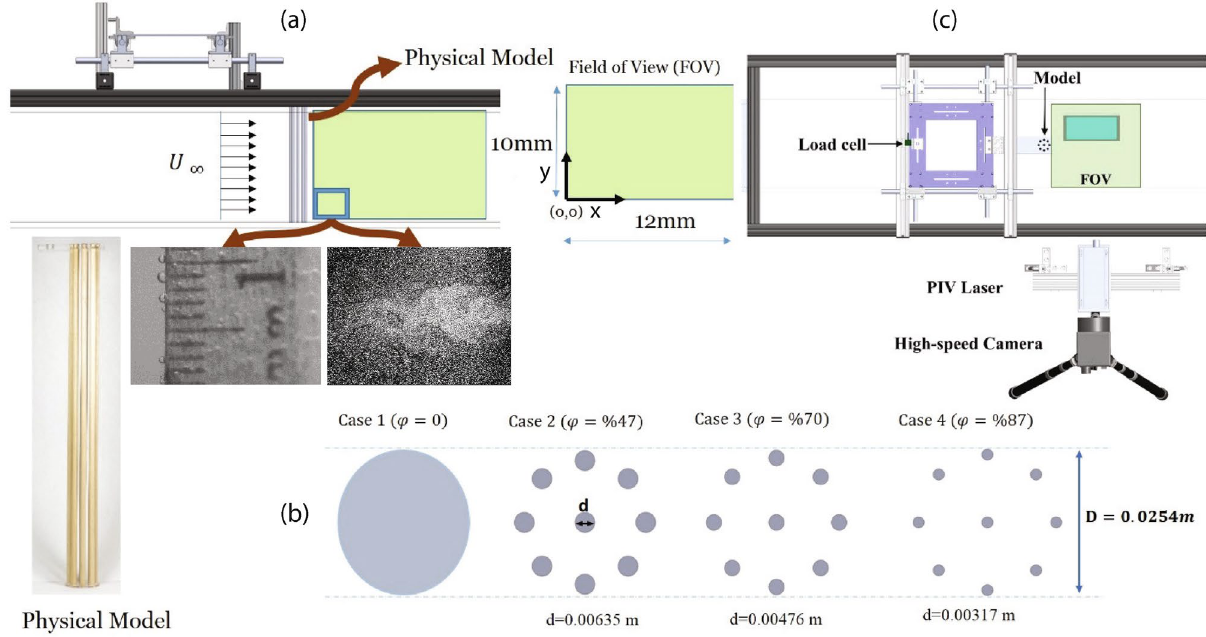
Figure 12. Schematic of the experimental setup and field of view (FOV) located in the mid-depth. ( a ) Side view of the experimental setup. ( b ) a picture of one physical model along with path configurations for different porosities. ( c ) top view of the experimental setup with simplified mangrove root models. The closed-loop water tunnel cross-section is 25 cm × 25 cm with the blockage ratio of 10%. The setup includes a recirculating flume, an air-bearing system to mount the models, a high-speed camera, and PIV laser. A 45 a bottom-up view of the flow field.